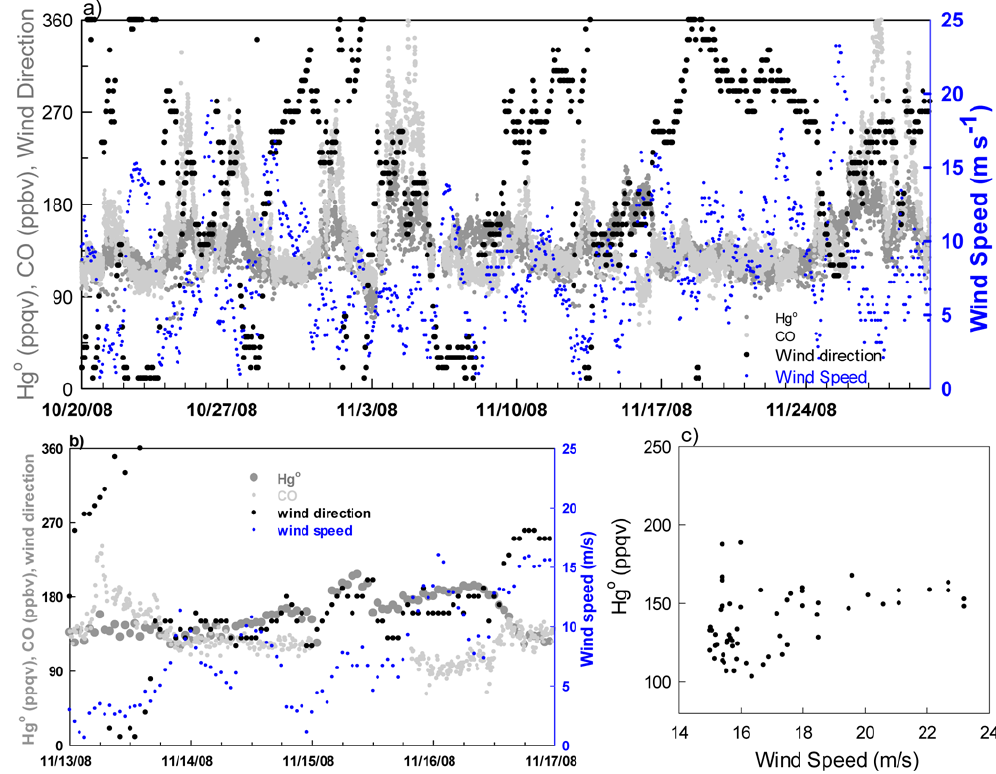
Fig. 1. (a) Wind speed (blue dots) and direction (solid black circles), mixing ratios of Hg 0 (dark grey) and CO (light grey) at AI (marine) during 20 October–30 November 2008, (b) a zoom-in on 13–17 November 2008 and (c) the Hg 0 -wind speed correlation with r 2 = 0 . 18, slope = 3.7ppqv per 1ms − 1 for the zoom-in